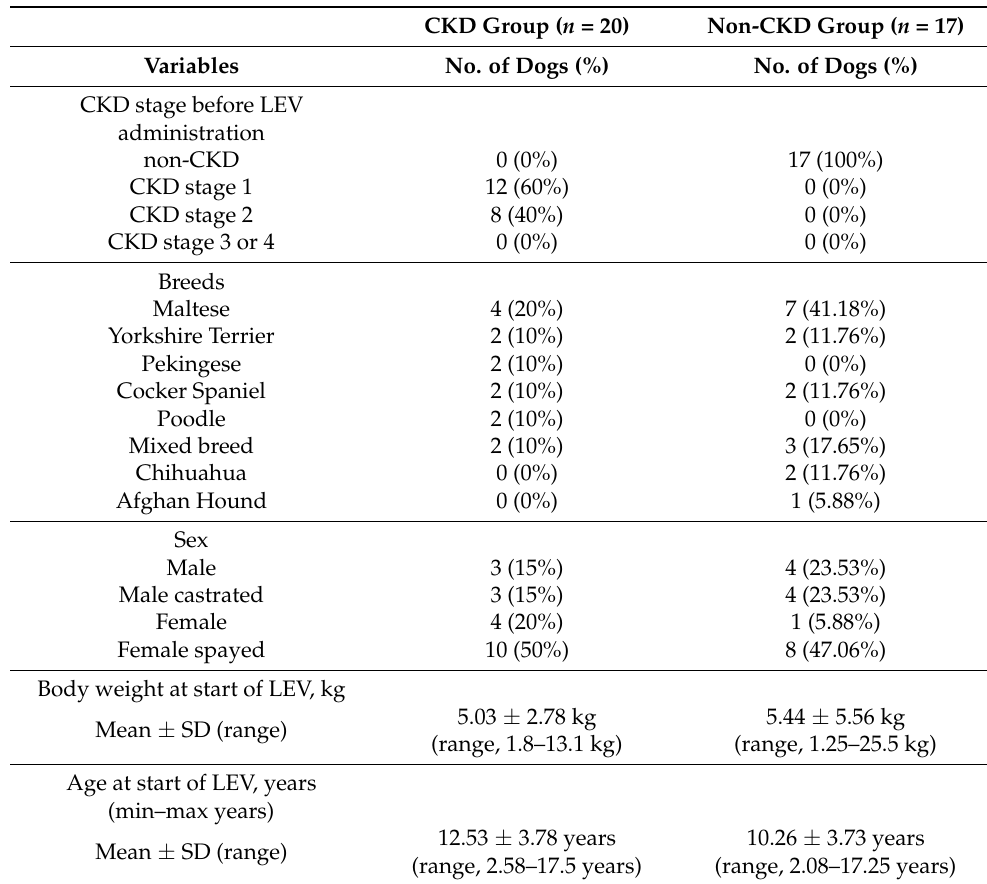
Table 1. Characteristics of patients with the CKD group/non-CKD group in the present study.